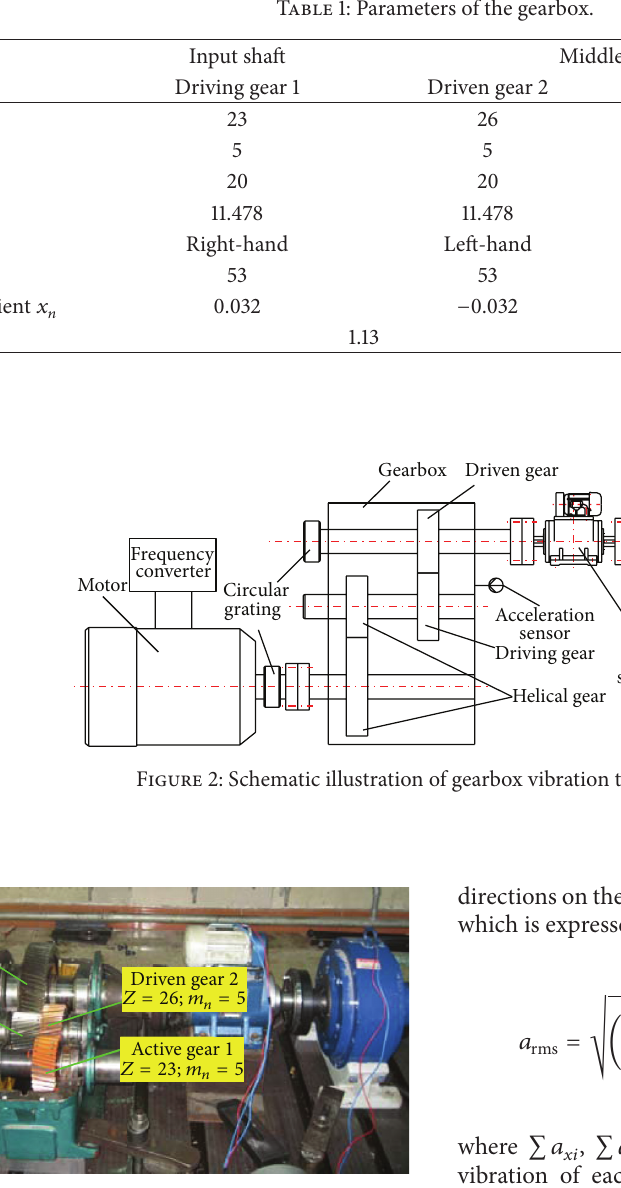
Figure 3: Gearbox internal